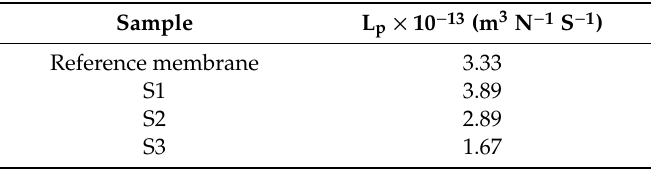
Figure 7. Water fluxes of the chitosan membrane (reference sample) and the irradiated chitosan membrane at different accelerating voltages of ion beams. Table 4. Hydraulic permeability of samples.